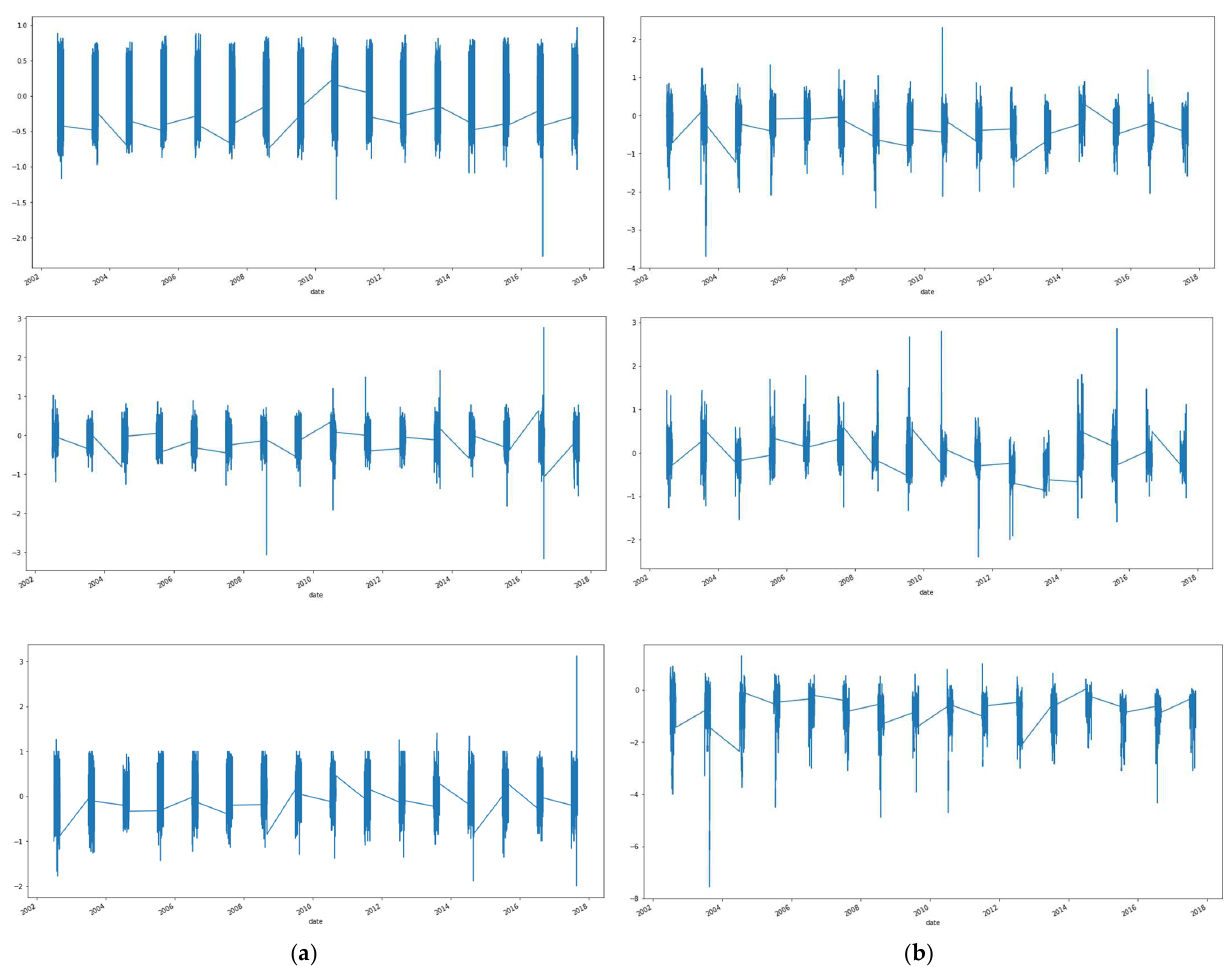
Figure 7. Distribution of β syn , β wet , and β ws in Beijing ( a ) and Shanghai ( b